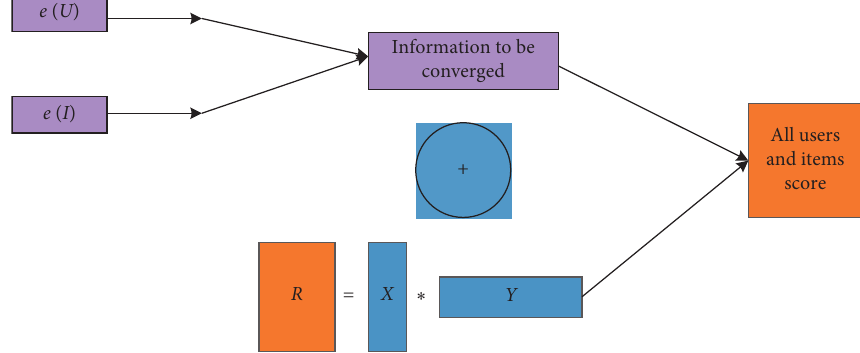
Figure 3: Process of information convergence.